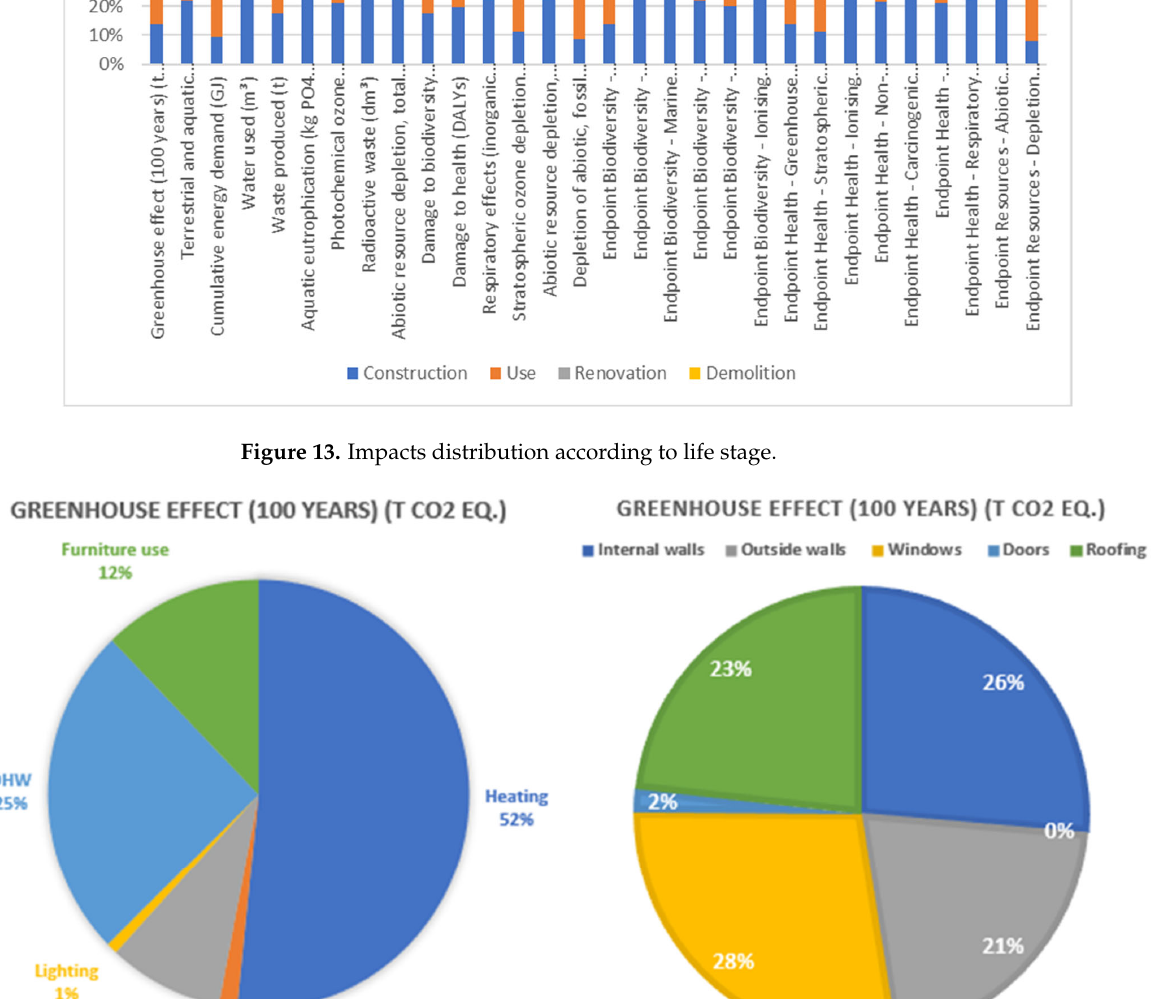
CivilEng 2022 , 3 , FOR PEER REVIEW